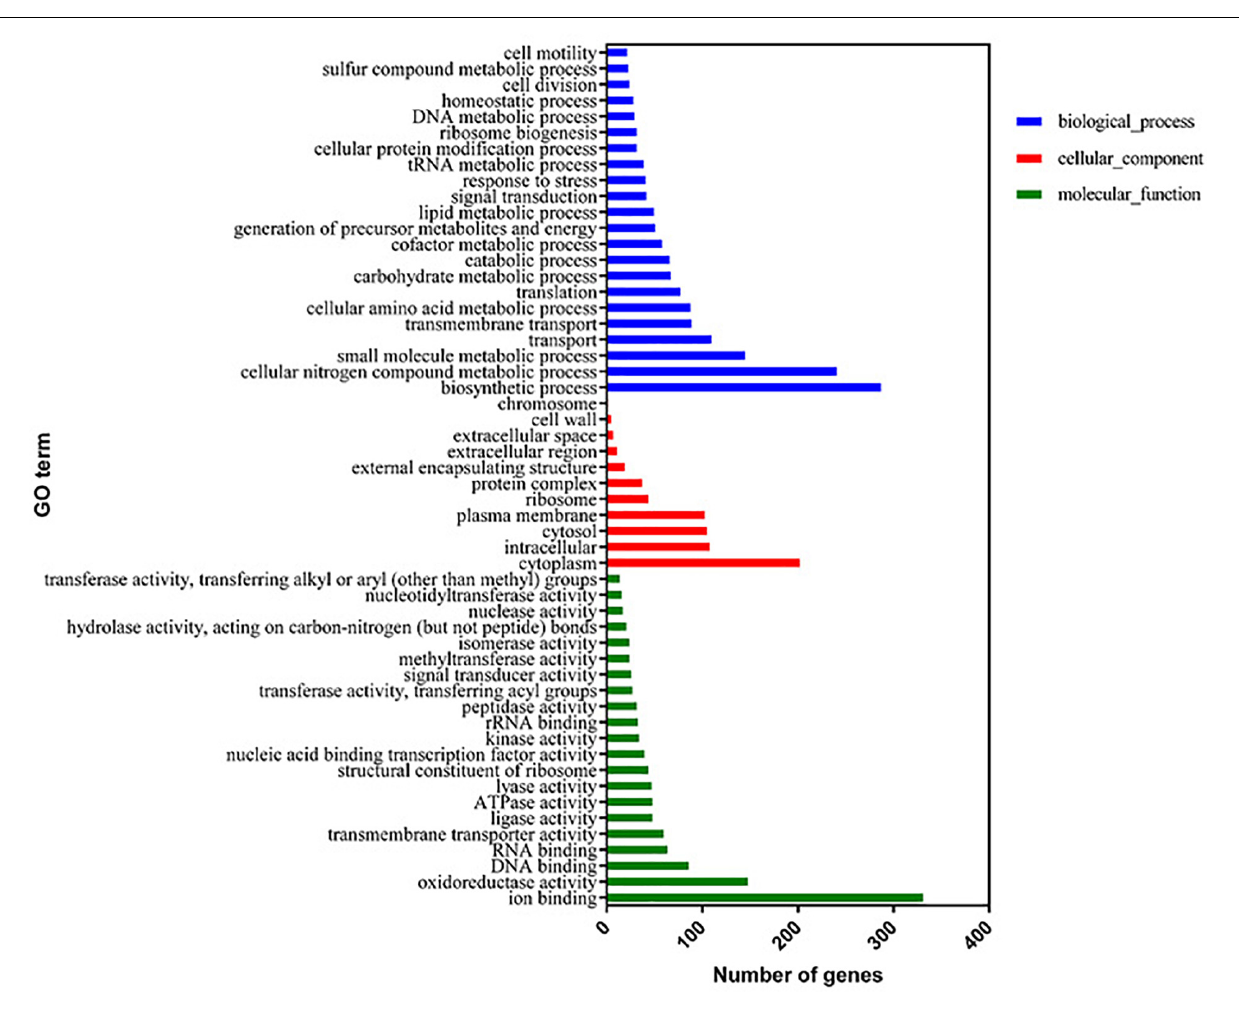
FIGURE 5 | Significantly enriched Gene Ontology categories ( q -value < 0.05) of differentially expressed genes based on proteome sequencing analysis of the DADS-treated group compared to the control group. Three main categories were identified: biological process, cellular component, and molecular